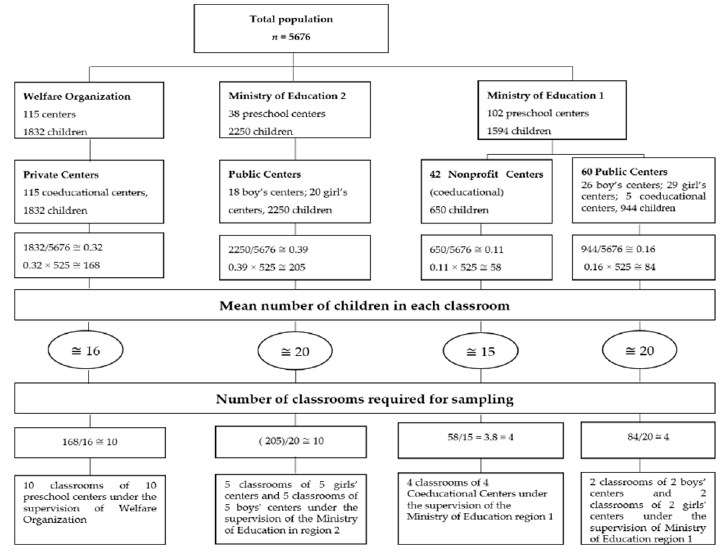
Figure 1. Process of sampling in this study.